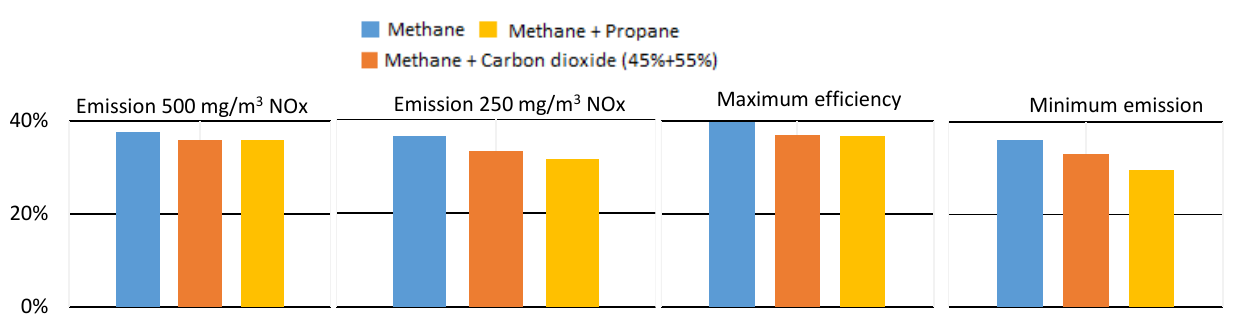
Fig. 8. Genset efficiency at 100% load for different NO x emission settings